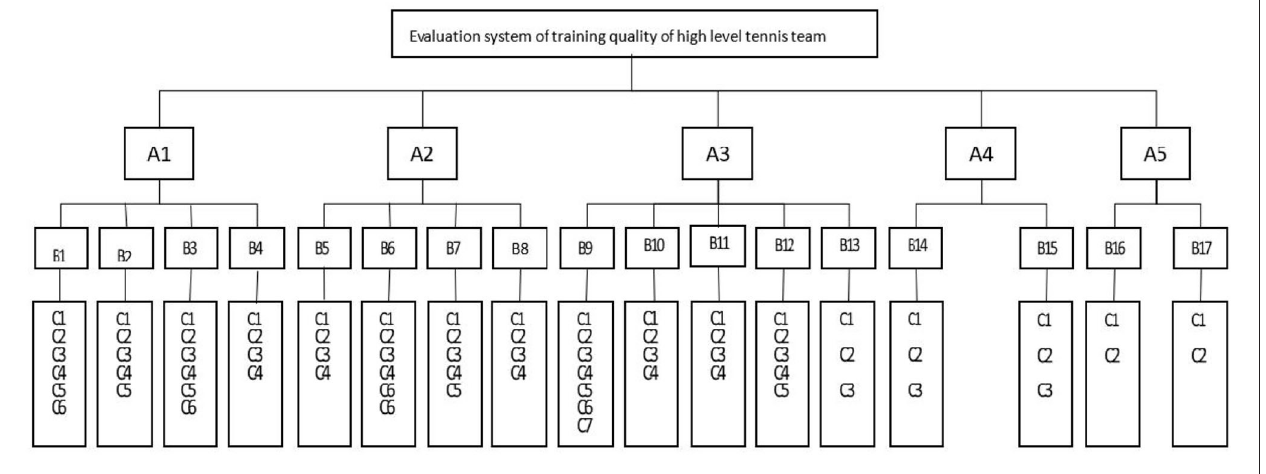
FIGURE 3 | Hierarchy chart of training quality evaluation for high-level tennis